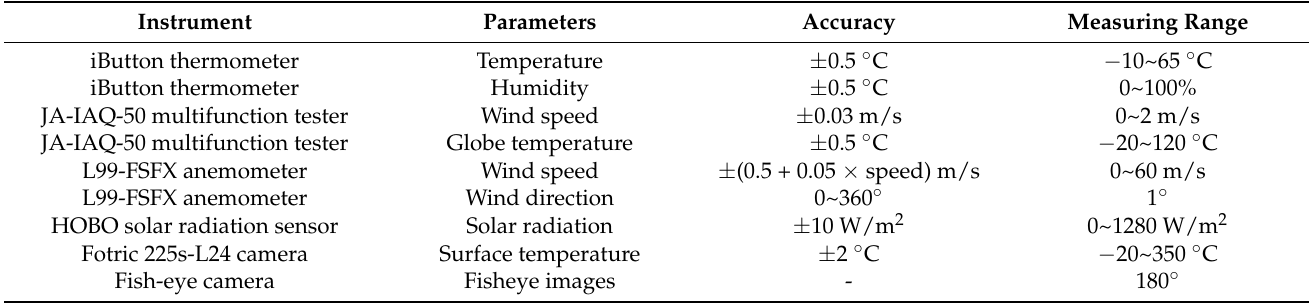
Table 2. The measurement parameters and devices used for